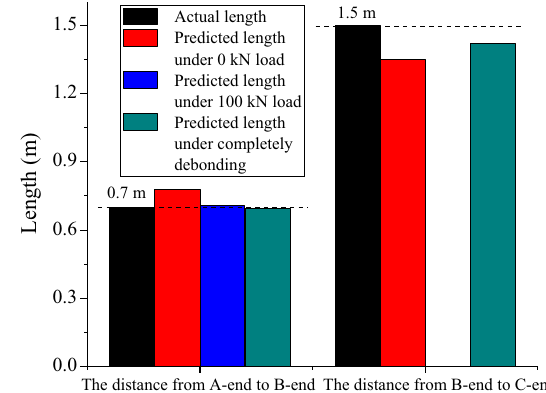
Fig. 4 The comparison between actual bond length and the length obtained based on wave propagation analysis